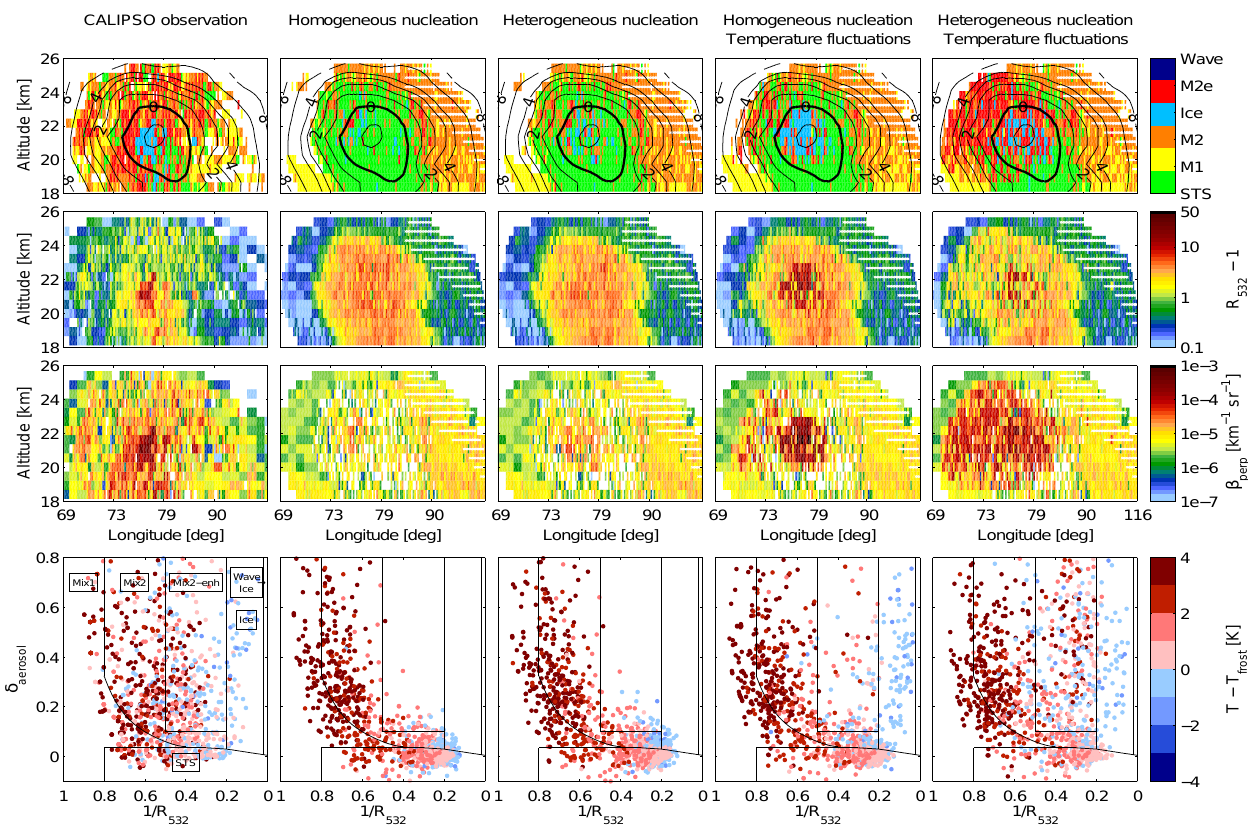
Fig. 6. Same as Fig. 5, but for Orbit 2 on 18 January 2010: CALIPSO orbit track 2010-01-18T21-45-30Z.